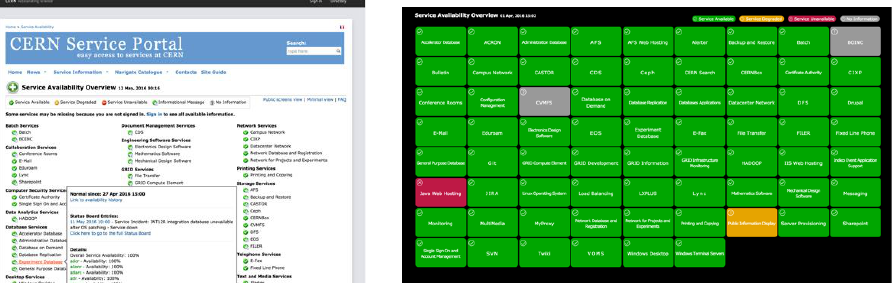
Fig. 3. The Service Availability Overview page and screen